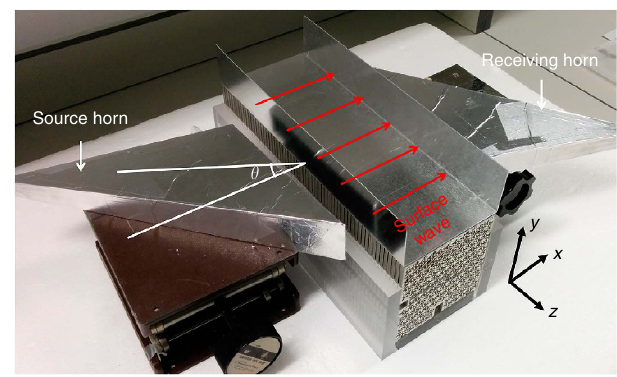
Figure 8 | Experimental set-up for surface transmission measurements. Two sectoral horns with sample tilted angles of 35 (cid:2) or 50 (cid:2) are used to emit and receive microwave. The sample has 11, 13 and 60 periods in the x , y and